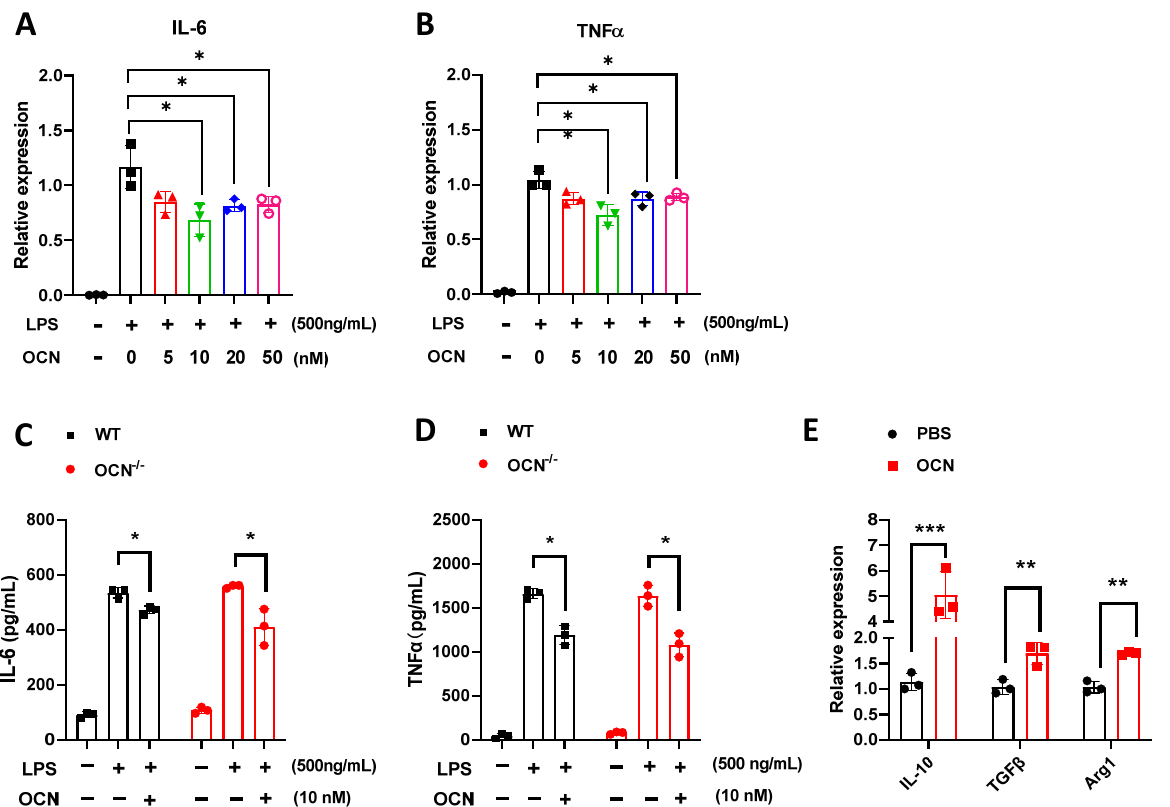
Figure 2. OCN inhibits the production of pro-inflammatory factor in macrophage. ( A , B ) Effects of OCN treatment on the mRNA expression of pro-inflammatory genes, i.e., IL-6 ( A ) and TNF α ( B ), in LPS (500 ng/mL) treated peritoneal macrophages from WT mice. Data are presented as means ± SD ( n = 3 biological replicates). * p < 0.05 and ** p < 0.01, as compared to PBS. ( C , D ) Cytokine levels in a culture medium of peritoneal macrophage from WT and OCN − / − mice. Peritoneal macrophages were treated with LPS (500 ng/mL), together PBS or OCN (10 nM) for 12 h, and the levels of IL-6 ( C ) and TNF α ( D ) in culture medium were measured by ELISA analysis. Data are presented as means ± SD. ( n = 3 biological replicates) * p < 0.05, as compared to PBS. ( E ) The mRNA expression analysis of genes associated with anti-inflammatory in peritoneal macrophages isolated from WT mice. Data are presented as means ± SD ( n = 3 biological replicates). ** p < 0.01 and *** p < 0.001, as compared to PBS.